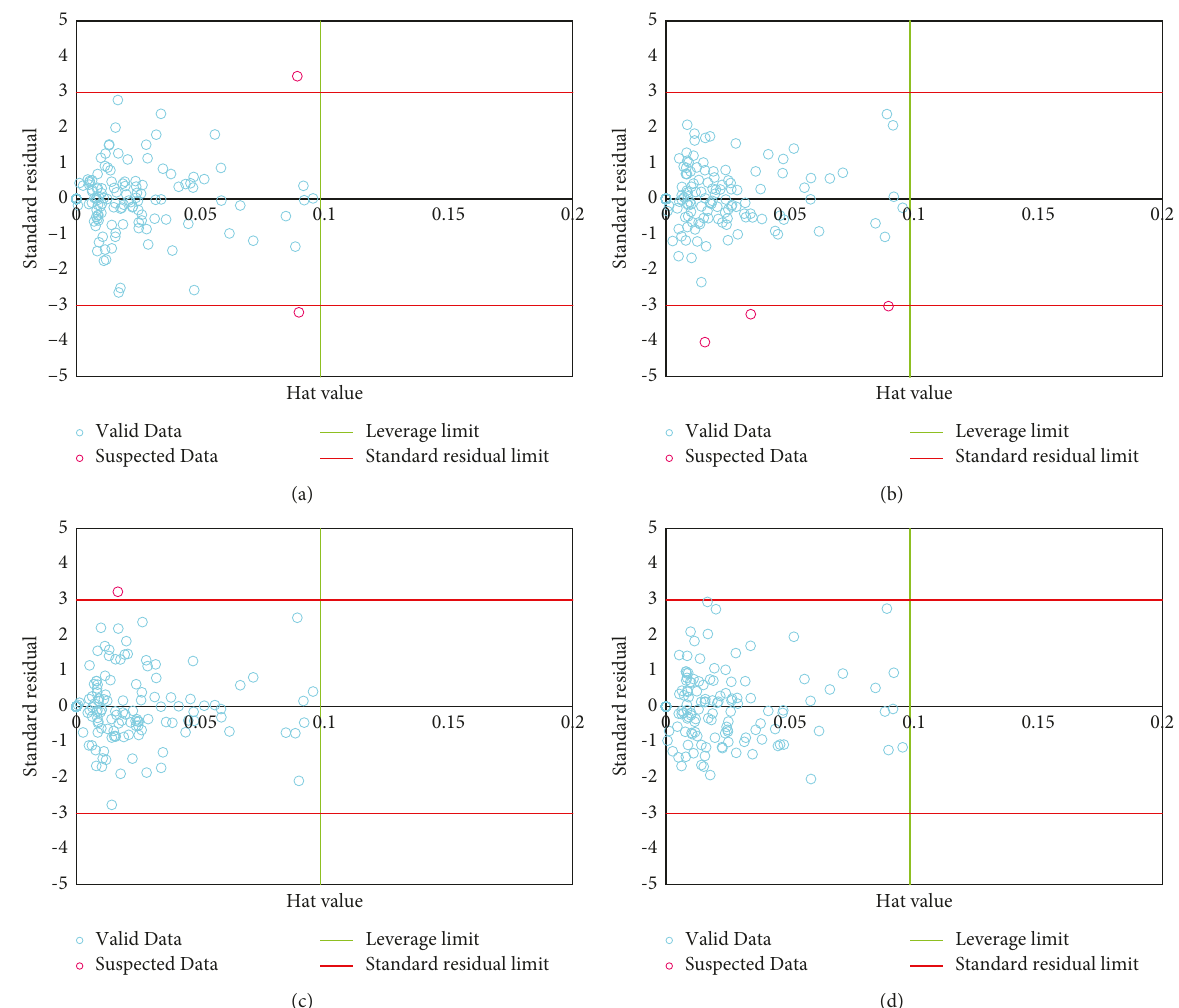
Figure 1: Detection of suspected data points using Hat analysis for models: (a) M, (b) E, (c) SE, and (d) RQ.